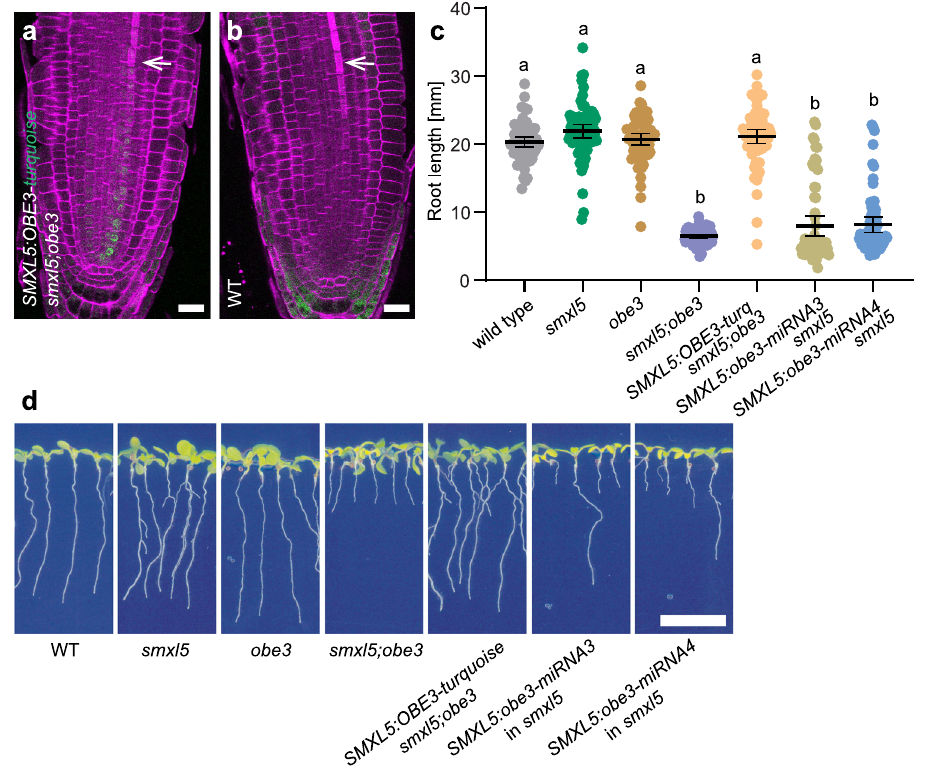
Fig. 7 | Phloem-speci fi c OBE3 expression is suf fi cient for promoting root growth. a , b Seven-day-old smxl5;obe3 root tips carrying an SMXL5:OBE3-turquoise reporter(greensignal, a )werecomparedtoanon-transformedwild-type(WT)root tip ( b ). Cell walls were stained by DirectRed (magenta). White arrows mark differ- entiated SEs. Scale bars indicate 20 µ m. Ten SMXL5p:OBE3-turq;smxl5;obe3 plants and fi ve wild-type plants were analyzed with similar results. c Root length quanti- fi cation of plants depicted in ( d ). Results from one representative experiment out